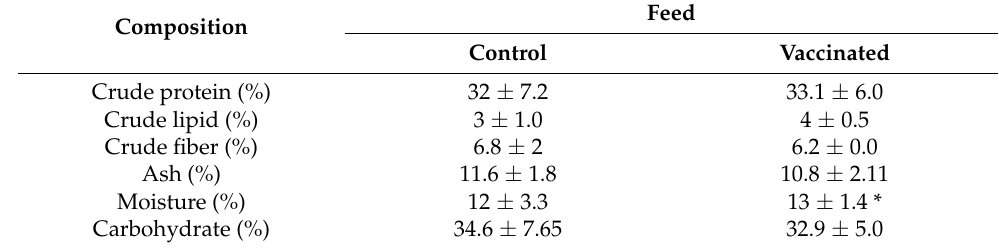
Table 4. Proximate composition. Asterisks indicate a significant difference ( p < 0.05) from the control. Composition